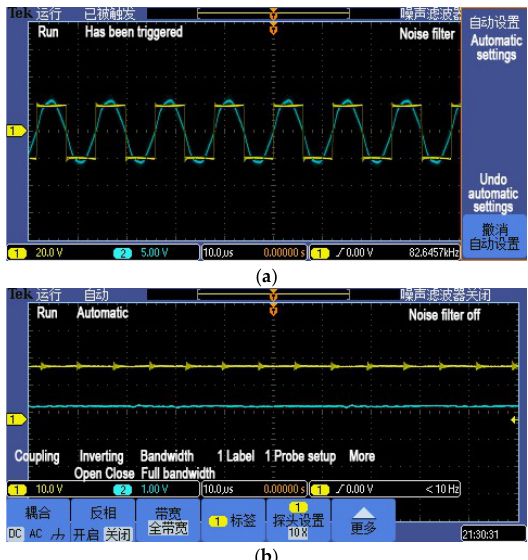
Figure 17. Sample value before and after the high-frequency inverter device under 10 cm distance. ( a ) High-frequency inverter output voltage and primary coil current under 10 cm distance and ( b ) DC power output current under 10 cm distance.